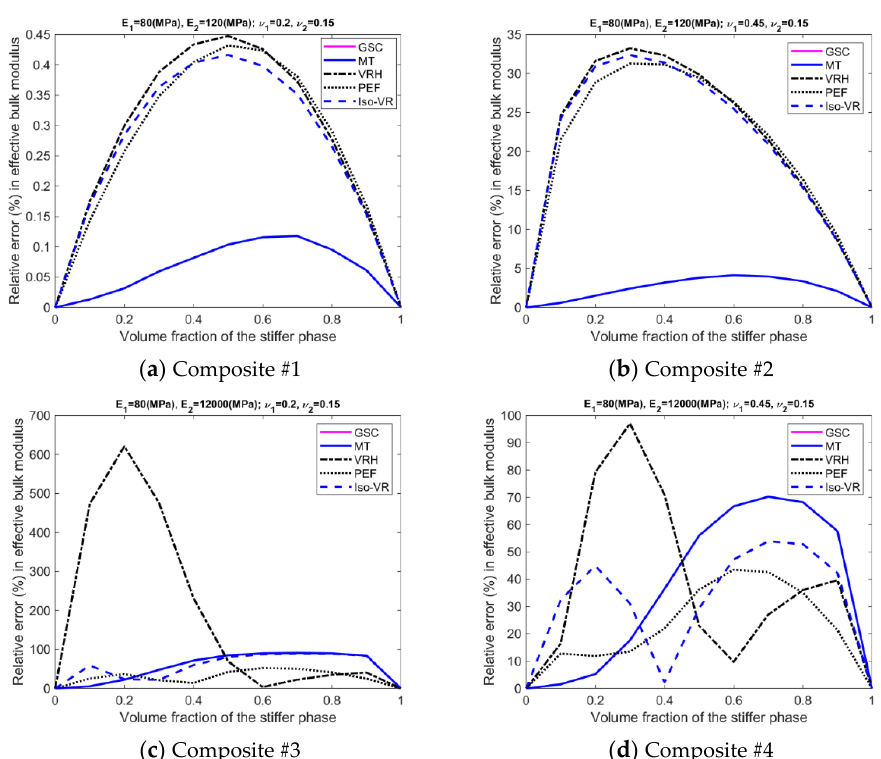
Figure A7. Relative error in effective bulk modulus. [Note: the pink line is coincident with the blue one].